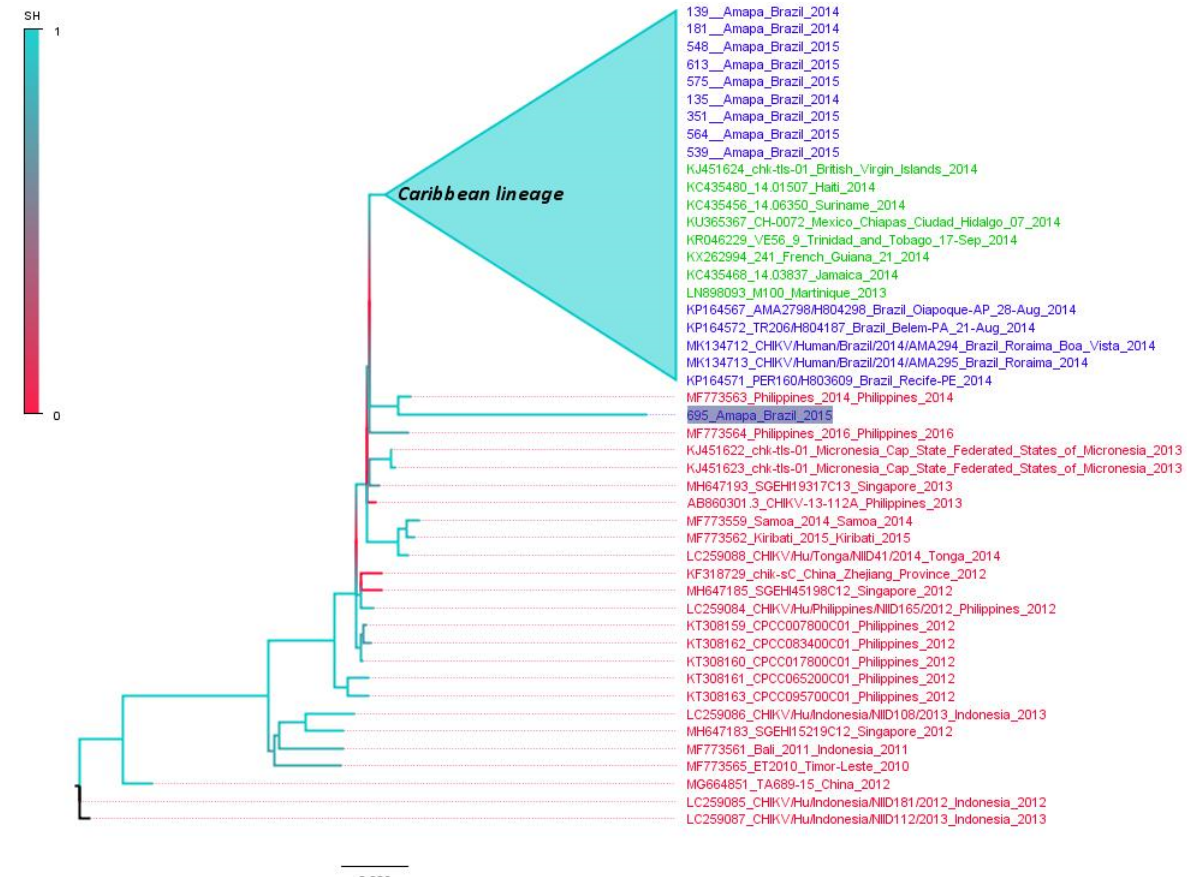
Figure 3. Maximum likelihood tree of CHIKV-Asian lineage. The unrooted tree was constructed using reference genomes of CHIKV-Asian lineage. Sequences from Brazil are indicated in blue. Sequences from Caribbean countries are in green color and sequences from South Asia/Oceania are in red color. The cluster composed by Caribbean sequences plus almost all Brazilian sequences is labeled. The Brazilian sequence related with a Philippine sequence is highlighted. The branch support is indicated by a color scale of 0 to 1, and is based on the Shimodaira–Hasegawa-like test. The tree was inferred using the TN-93 model plus gamma correction. Horizontal bar indicates the nucleotide substitution per base. For better visualization of the tree some sequences were collapsed (blue triangles).